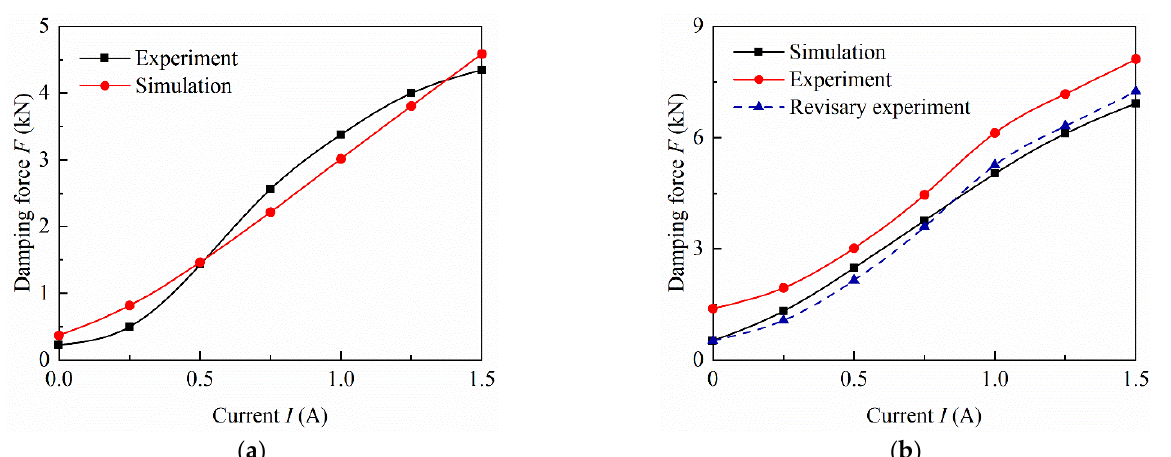
Figure 21. Comparison of damping force between simulation and experiment: ( a ) initial; ( b ) optimal.